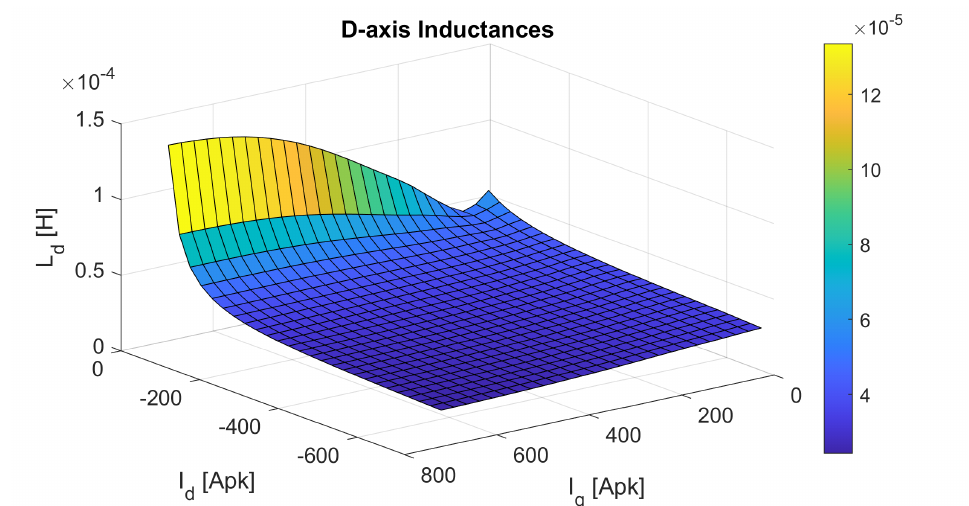
Figure 5. Inductance map of d -axis ( L d ) obtained with the Frozen Permeability method.